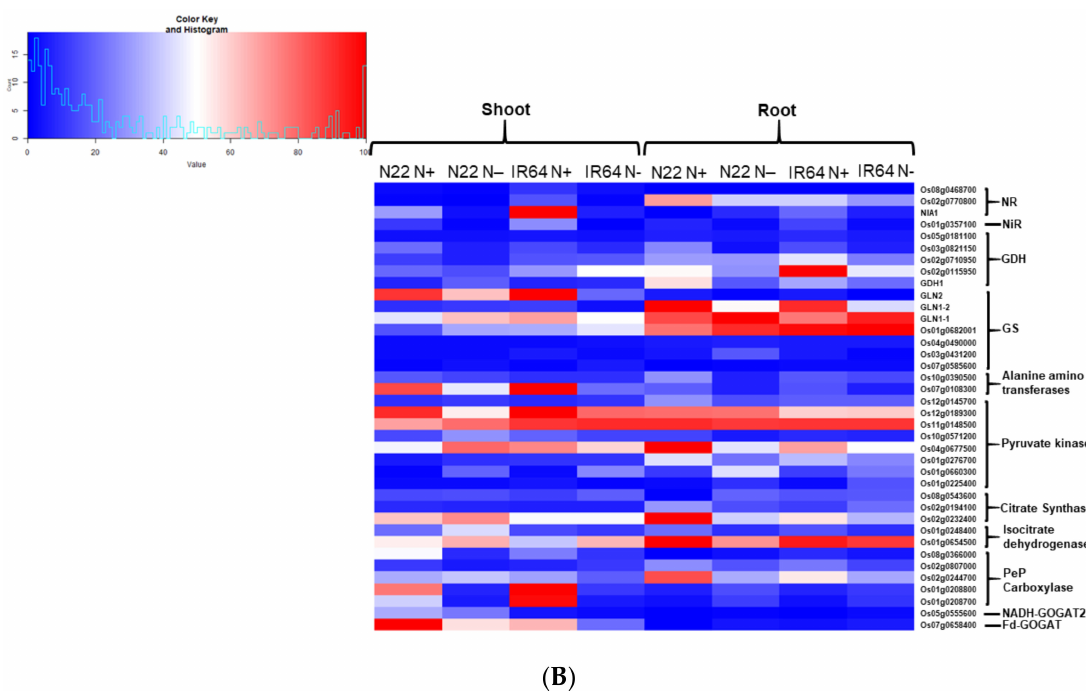
Figure 4. Enzyme activities and gene expression pattern in two rice genotypes, IR 64 and Nagina 22, under optimal (N+) and low N (N − ). Specific enzyme activities of nitrate reductase (NR), nitrite reductase (NiR), pyruvate kinase (PK), citrate synthase (CS), glutamate synthase (GS), glutamate dehydrogenase (GDH), glutamine oxoglutarate amino transferase (GOGAT), and isocitrate dehydrogenase (ICDH) (A). The expression patterns of genes encoding for enzymes involved in nitrogen and carbon assimilation in root and shoot tissues. The heat map represents the relative expression levels of 38 genes out of the total 71 genes examined based on FPKM values (> 5 in at least one of the samples) using RNA sequencing (RNA-seq) data (B).